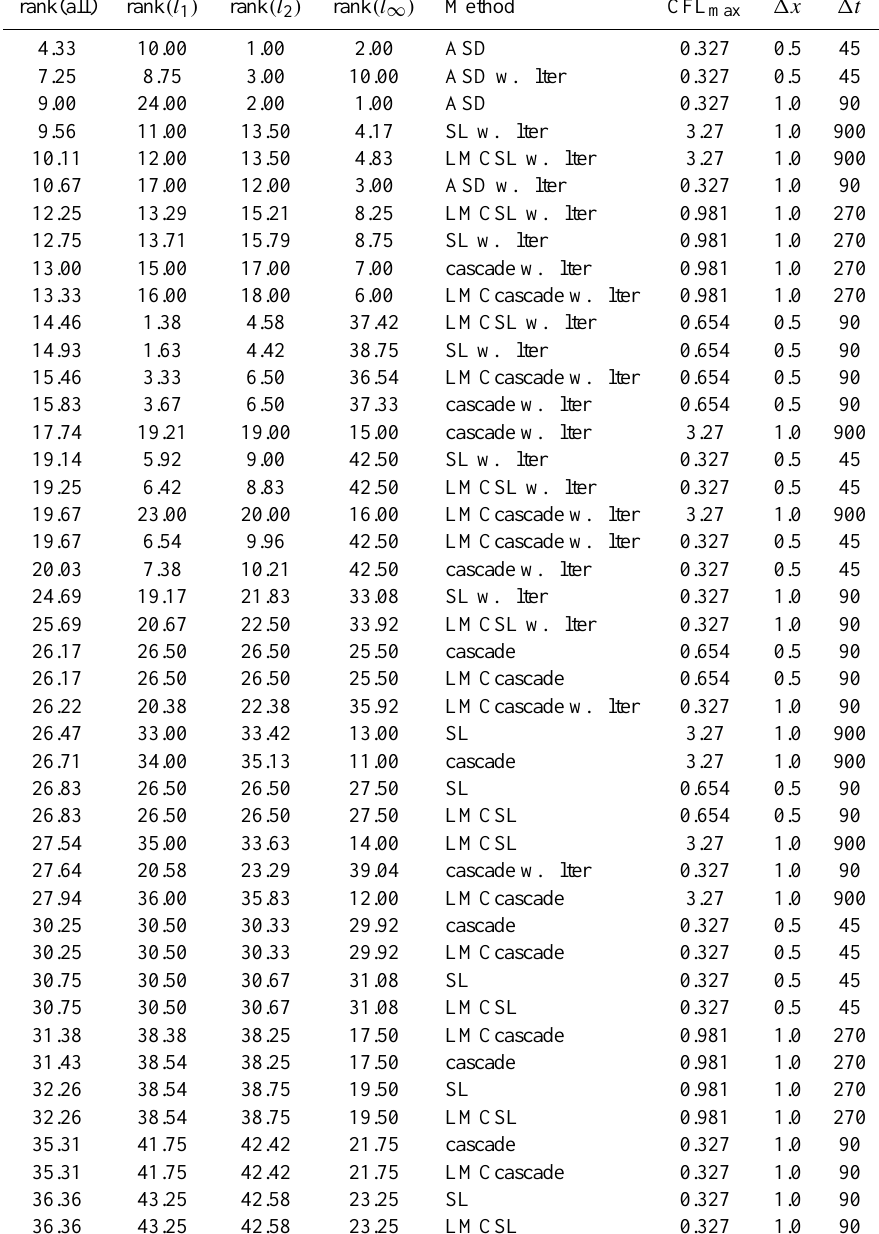
Table 6. Ranking results for the slotted cylinder with pure advection. Showing rank of the ranked error measures, rank of error measure l 1 , l 2 , and l ∞ followed by method, maximum Courant number, grid resolution, and time